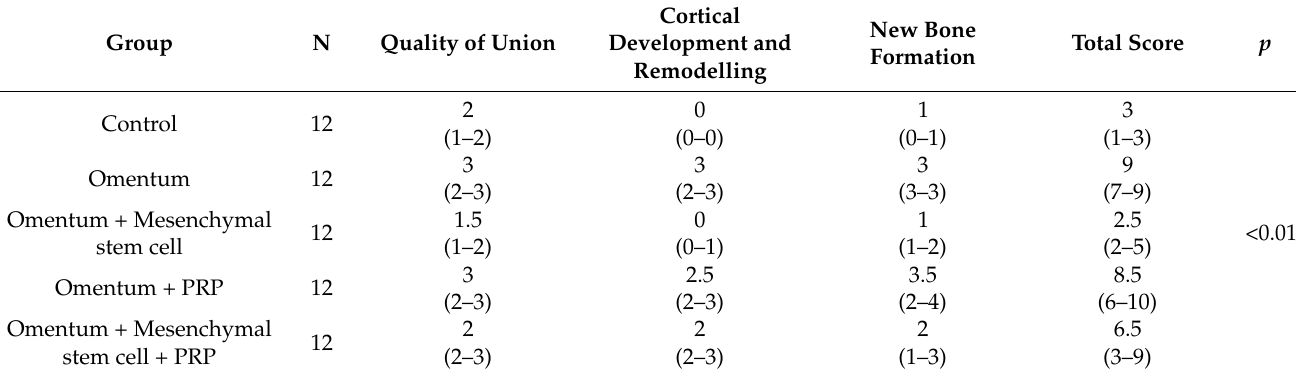
Table 4. Histopathological assessment scoring of groups according to Salkeld et